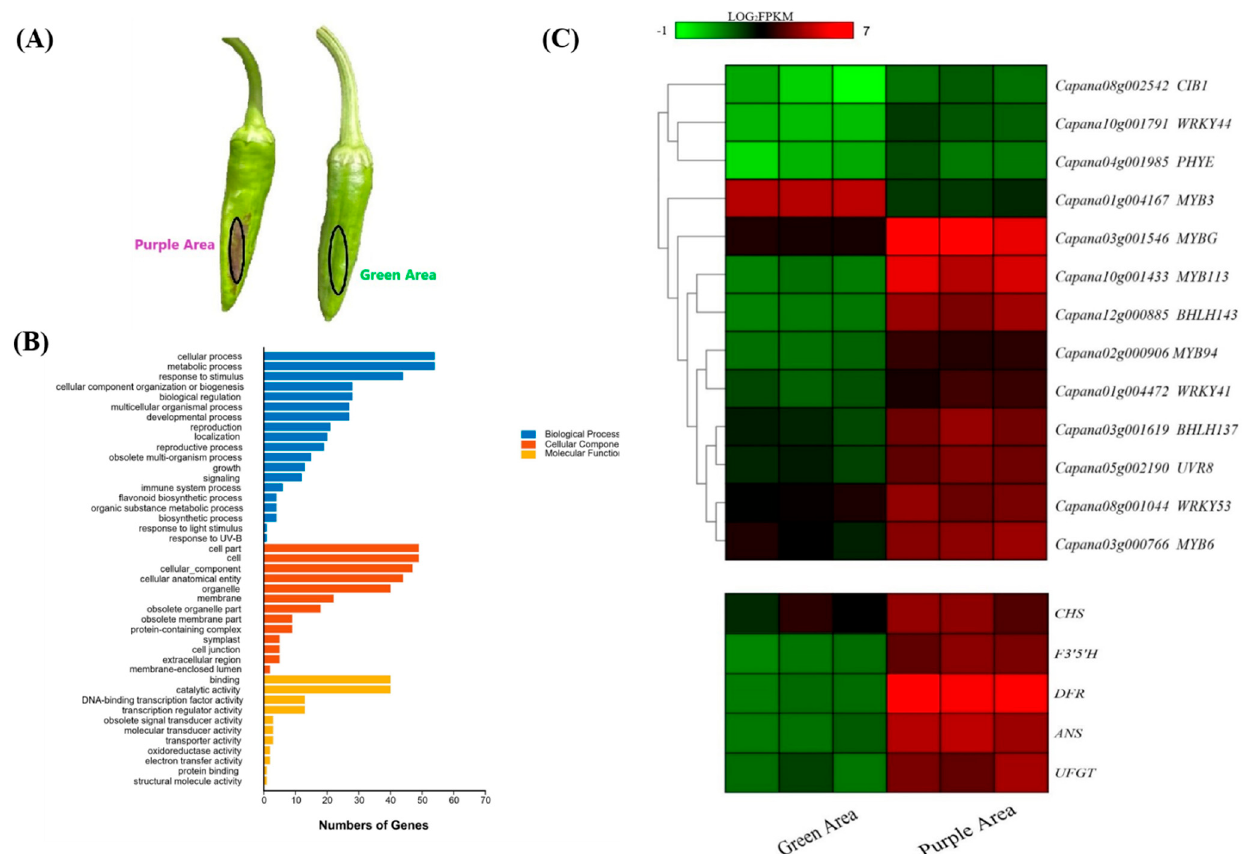
Figure 2. Transcriptome analysis between purple area and green area of pepper fruit. ( A ) Sampling site of pepper fruit for RNA-seq. ( B ) GO pathway analysis of differentially expressed genes. ( C ) FPKM analysis of anthocyanin-biosynthesis-related regulatory genes and anthocyanin structural genes among differentially expressed genes between purple area and green area. The color scale from green to red indicates the value of log 2 FPKM.